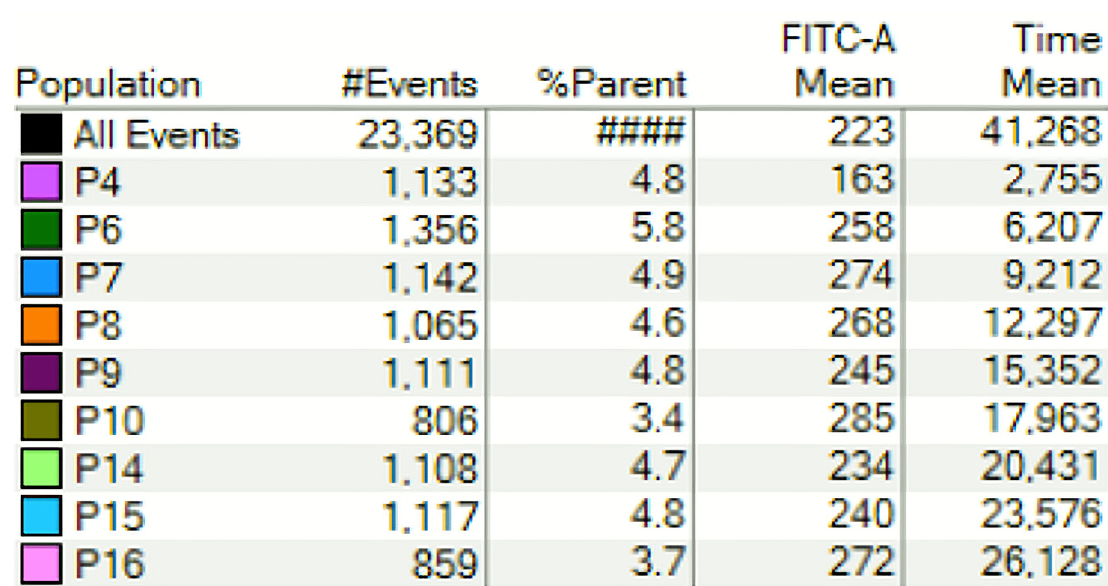
Figure 4. Flow cytometric analysis of intracellular calcium (iCa2+) generation kinetics in nasal epithelial cells. Intracellular calcium was measured using FLUO-4. Human nasal cells were gated accordingly to SSC and FSC. Dead cells were excluded using DAPI. Gating percentages and iCa2+ levels are shown.